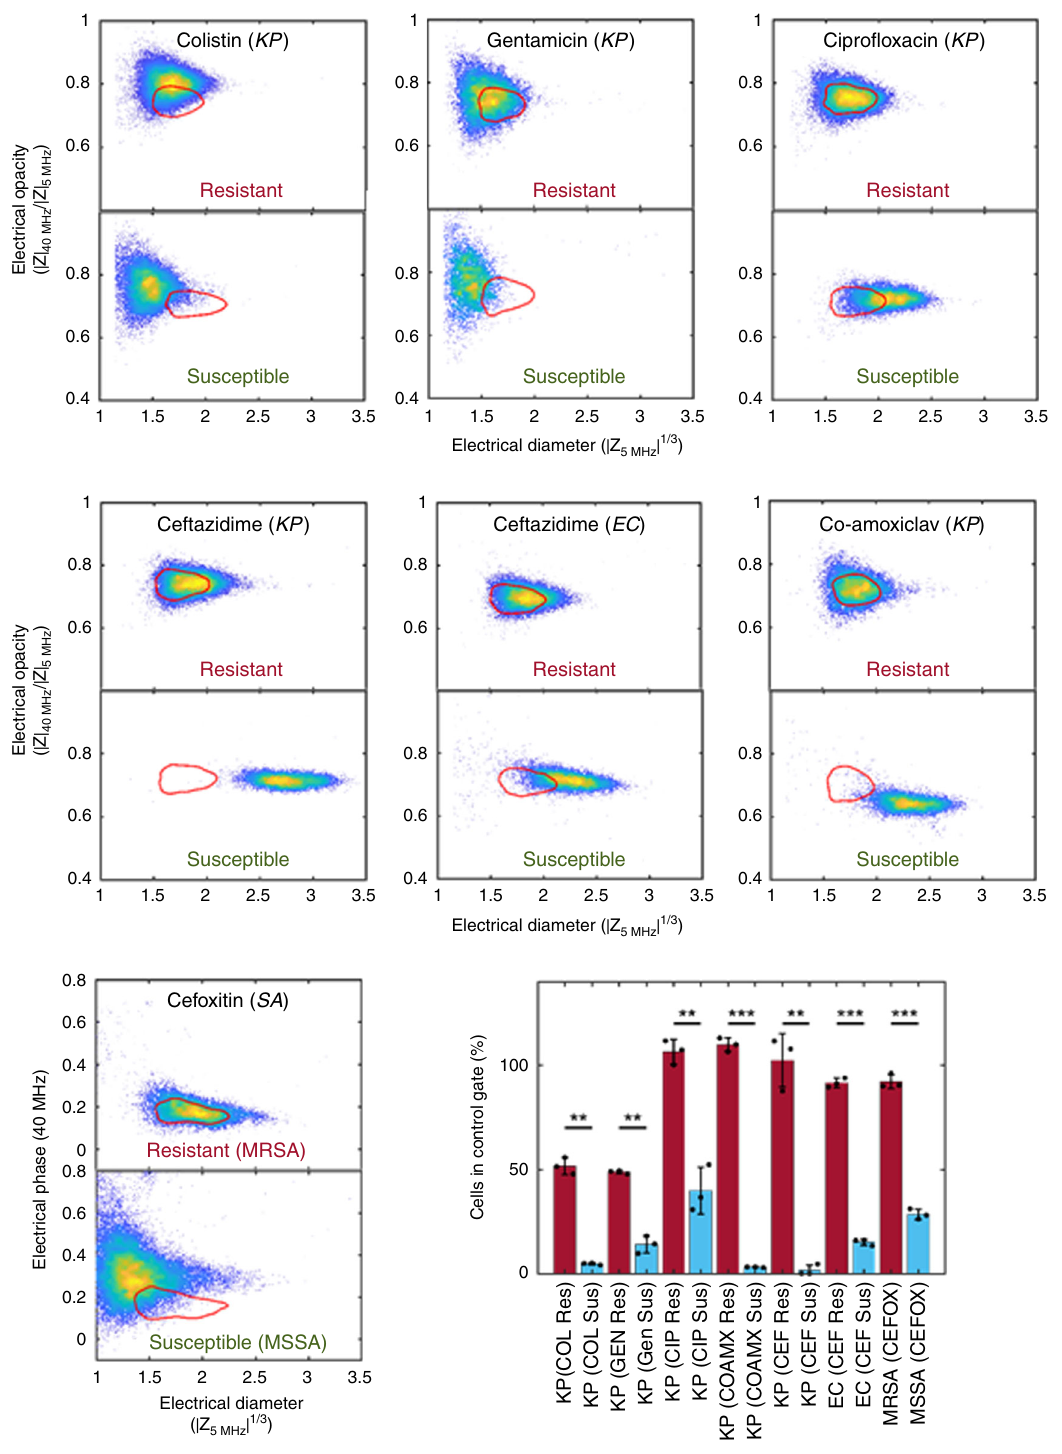
Fig. 5 Breakpoint analysis for different antibiotic mechanisms. Scatter plots for susceptible and resistant bacteria after exposure to different antibiotics (see inset labels) at the S / R clinical breakpoint. The fi gure shows K. pneumoniae (KP), E. coli (EC), and S. aureus (SA) exposed to antibiotics which have different modes of action. The bar chart shows the percentage of cells inside the unexposed contour (mean ± SD for three biological repeats, red bar: resistant strain, blue bar susceptible strain as determined by broth micro-dilution) * p < 0.05; ** p < 0.01; *** p < 0.001, with p values obtained using the Student ’ s t test for independent samples (one tailed), from left to right as follows: 1.04 × 10 − 3 , 1.83 × 10 − 3 , 1.36 × 10 − 3 , 1.53 × 10 − 3 , 2.06 × 10 − 3 , 1.96 × 10 − 6 , 1.33 × 10 − 5 . Source data are provided as a Source Data fi